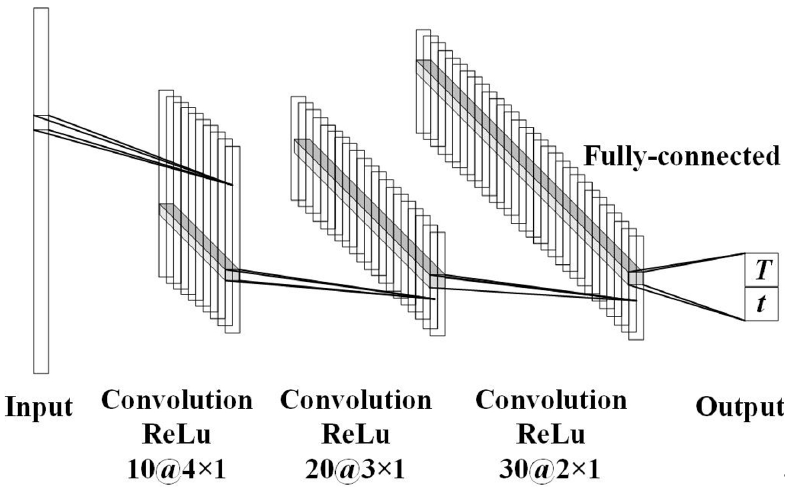
Figure 2. ConvNet architecture for the inversion of snow